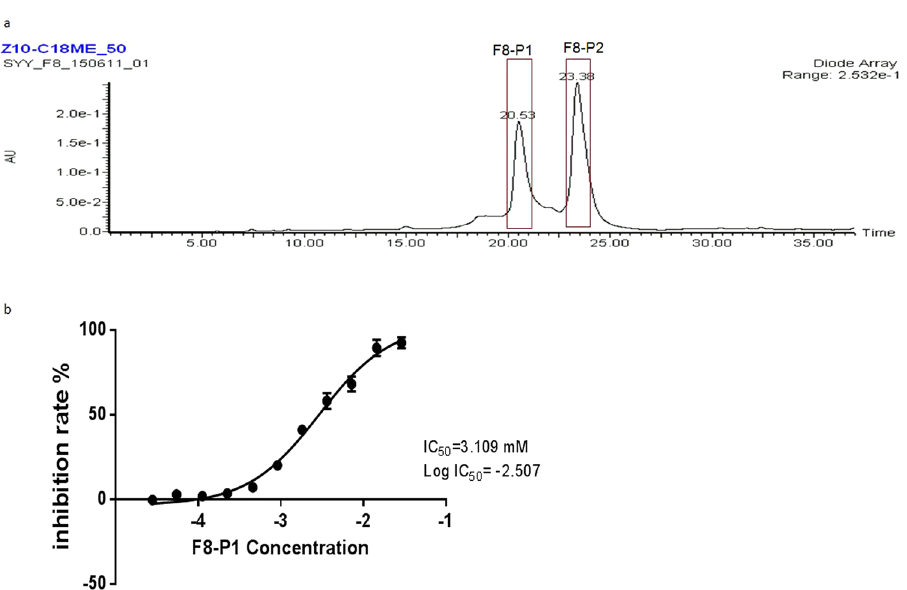
Figure 7. Analysis of the F8. ( a ) The two secondary fractions were collected (in red boxes). ( b ) Dose response of F8. Data represents mean ± SEM. (n =